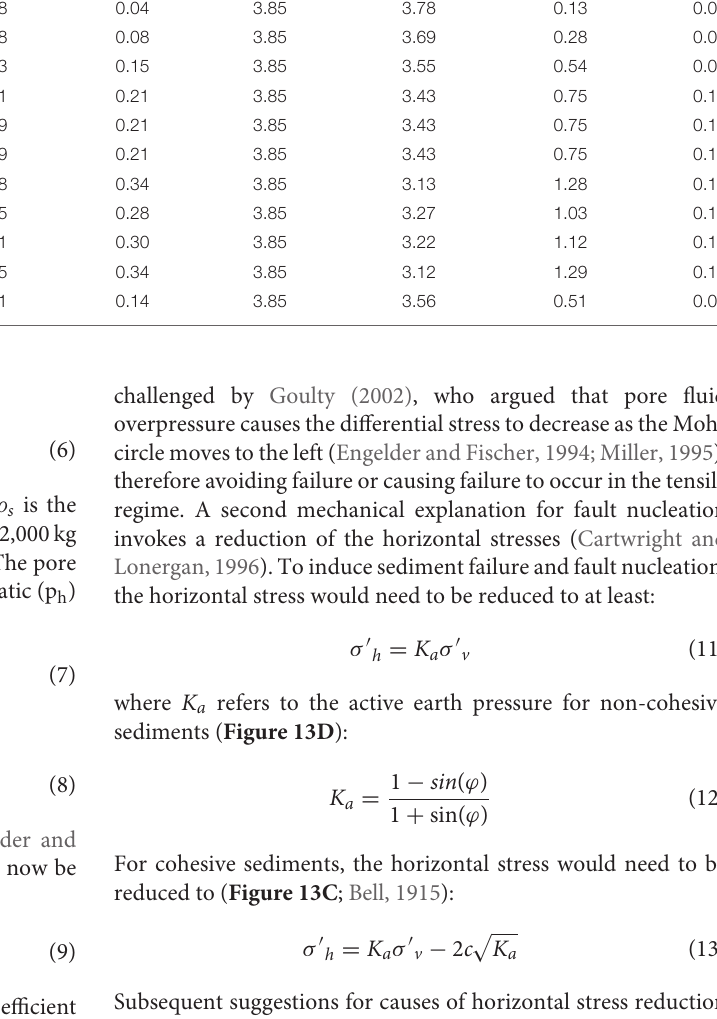
TABLE 1 | Area measurements and strain calculation for horizons shown on Figure 4 .